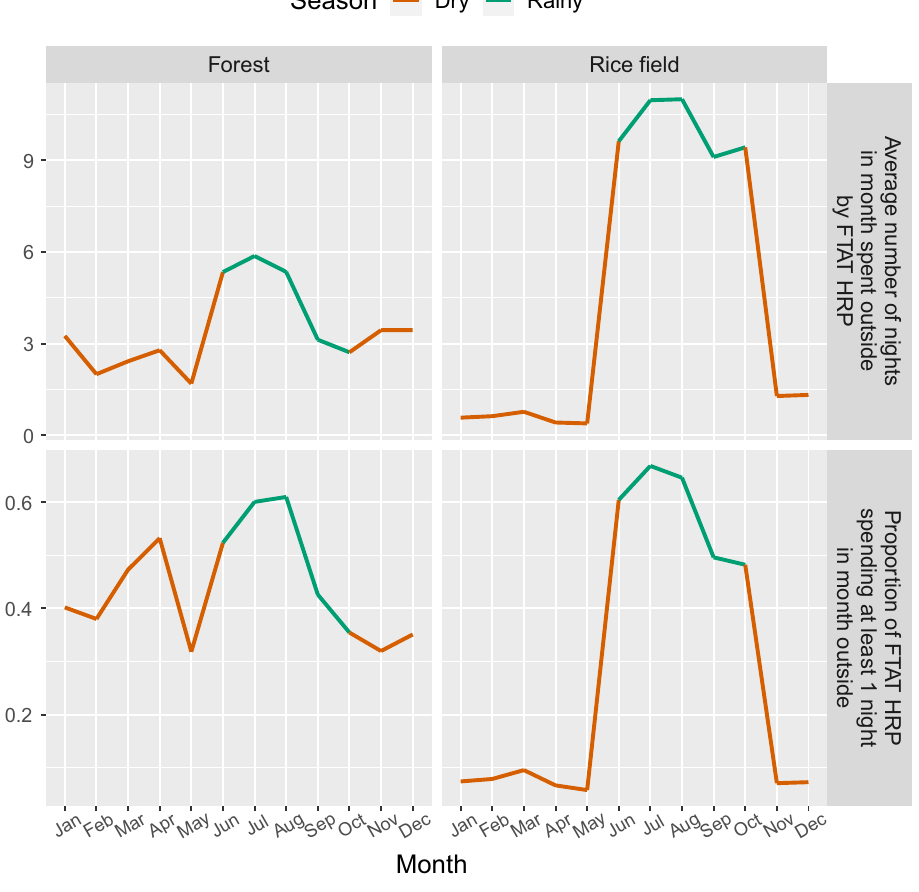
Figure 3. Seasonality of FTAT HRP: Top row—average number of nights spent outside in the forest or rice field by FTAT HRP individuals over time. Bottom row—proportion of FTAT HRP individuals spending at least 1 night in month outside in the forest or rice field over